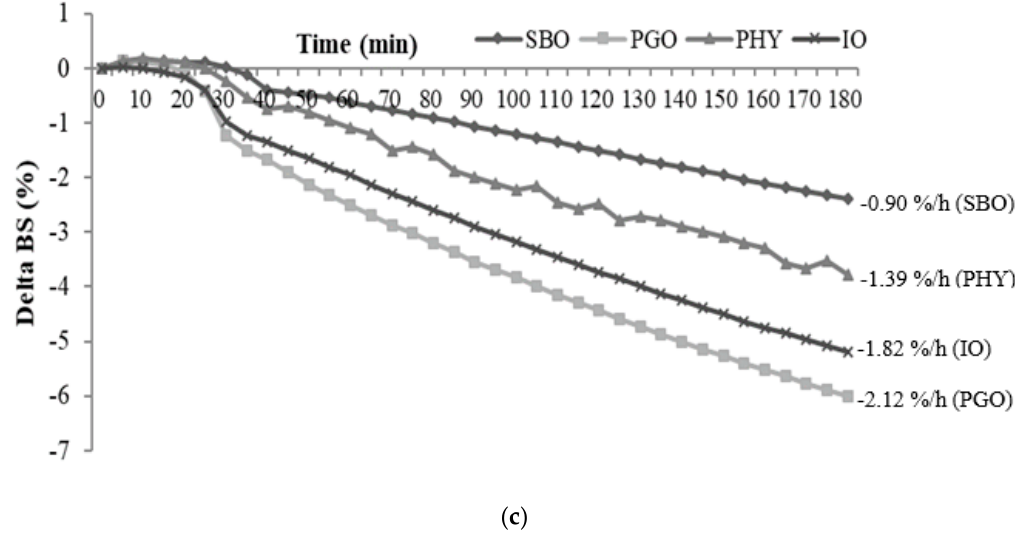
Figure 1. The mean particle sizes ( d 32 , μ m) ( a ); delta back scattering ( Δ BS) values (%) and Δ BS(t) rates (%/h) of creaming layer ( b ); and clarification layer ( c ) of the emulsified oils in digestion fluid. Statistical differences are indicated by different letters ( a , b ) where significant differences were detected ( p < 0.05). Abbreviation: SBO, soybean oil; PGO, pomegranate seed oil; PHY, physical blend; IO, interesterified oil.